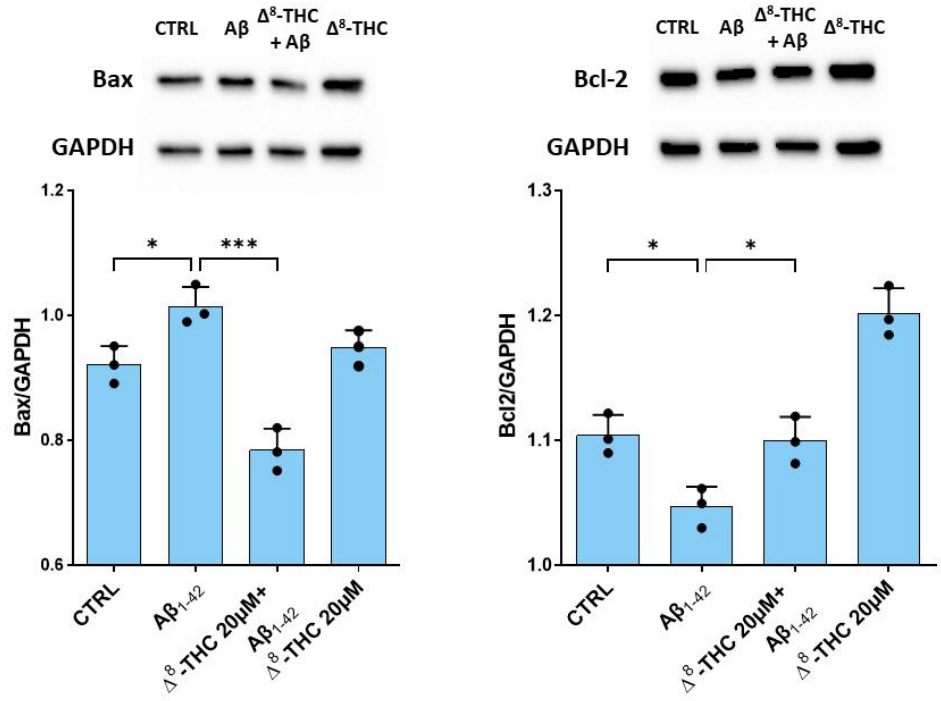
Figure 4. Western blot for Bax and Bcl-2. Aβ 1-42 treatment caused an increase in Bax and a reduction in Bcl-2 protein levels. Δ 8 -THC treatment restored protein levels of Bax and Bcl-2. N = 3 independent experiments. The results are expressed by mean ± standard deviation (SD). * p < 0.05; *** p < 0.001.